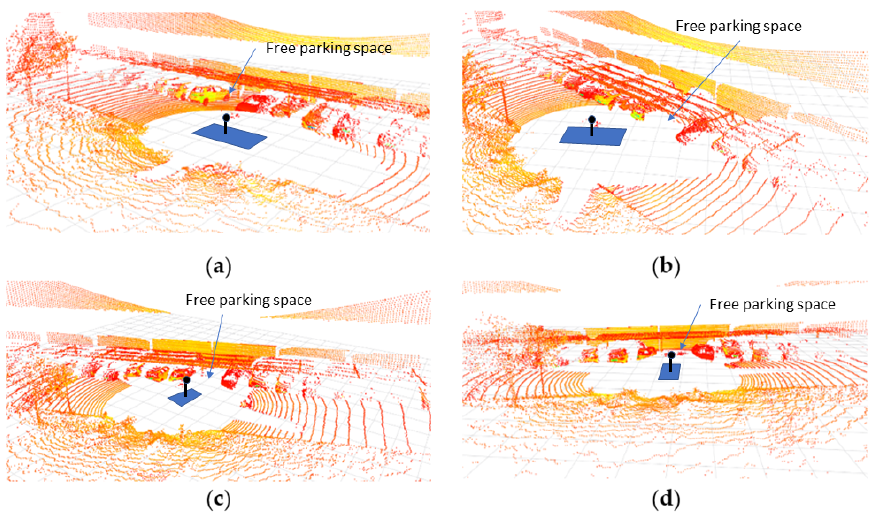
Figure 11. Example of a sequence of LiDAR frames during the parking maneuver in Case A. ( a ) Approximation; ( b ) reverse maneuver between M1(I) and ME; ( c ) reverse maneuver near ME; ( d ) final straight maneuver.